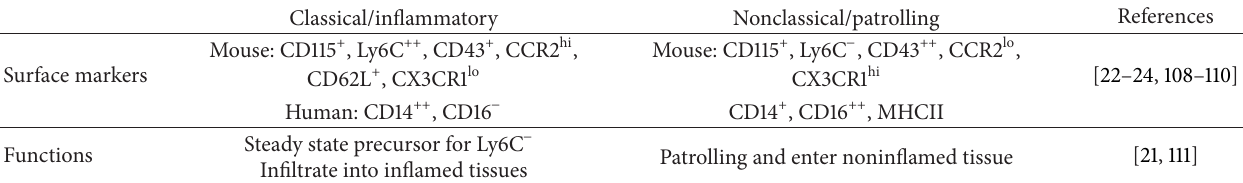
Table 1: Inflammatory (classical) and resident (nonclassical)